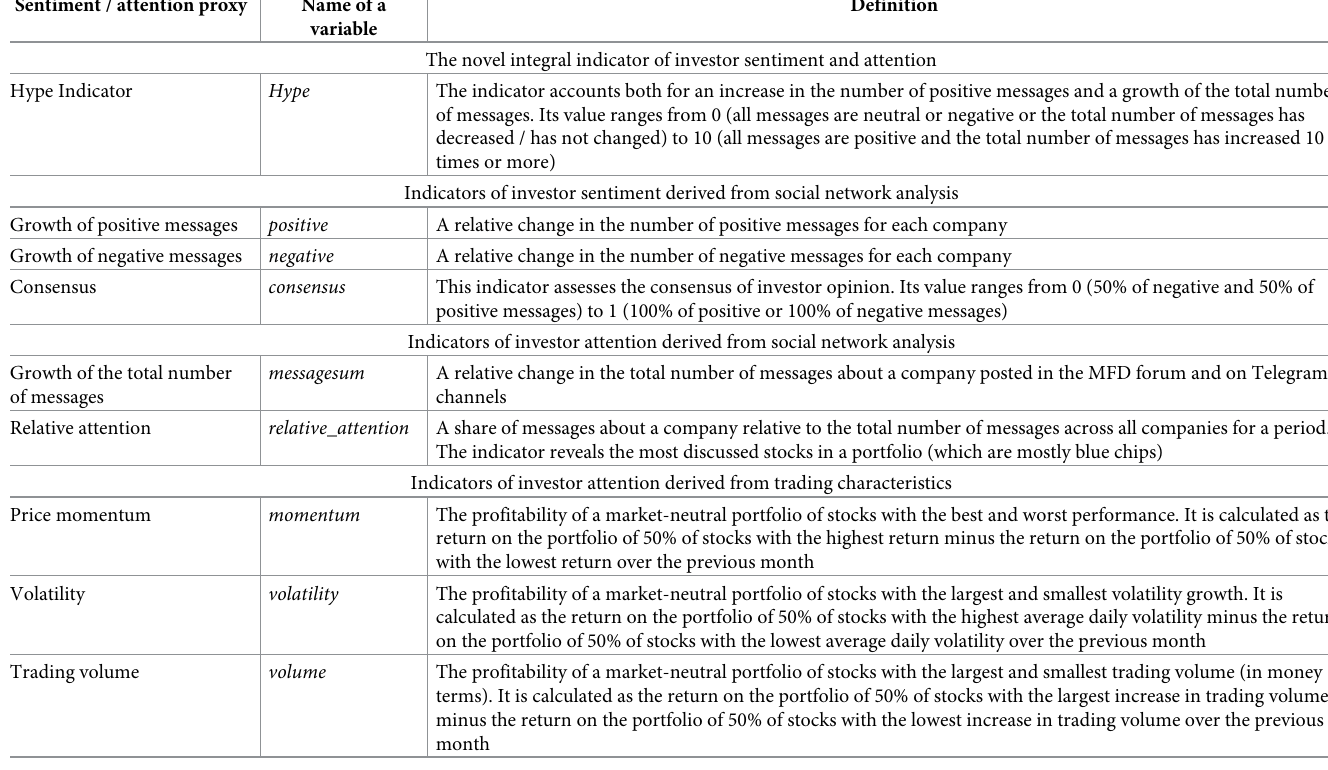
Table 4. Key filters for portfolio